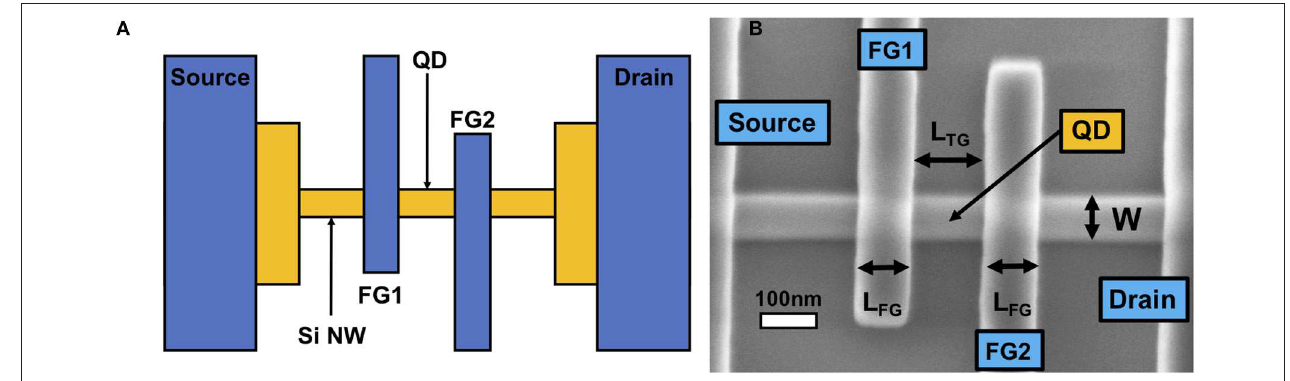
FIGURE 1 | Device schematics of the silicon nanowire transistor. (A) A 2D graphic of the nanowire transistor. TG is not shown to clarify the structure [46]. (B) A SEM image of the device before poly-Si deposition for TG. A quantum dot (QD) is electrically defined by inverting the entire channel by TG with V FG being 0 V.